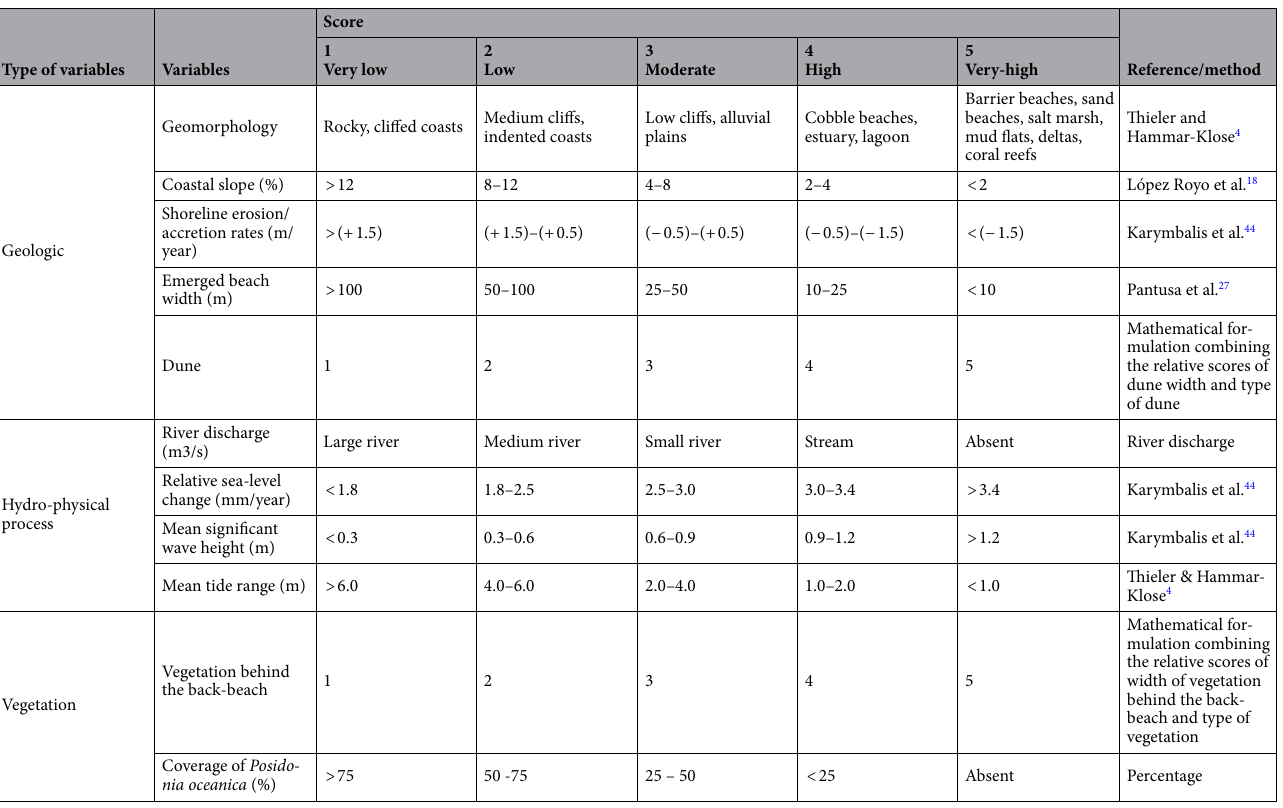
Table 3. Ranges of vulnerability scores for the